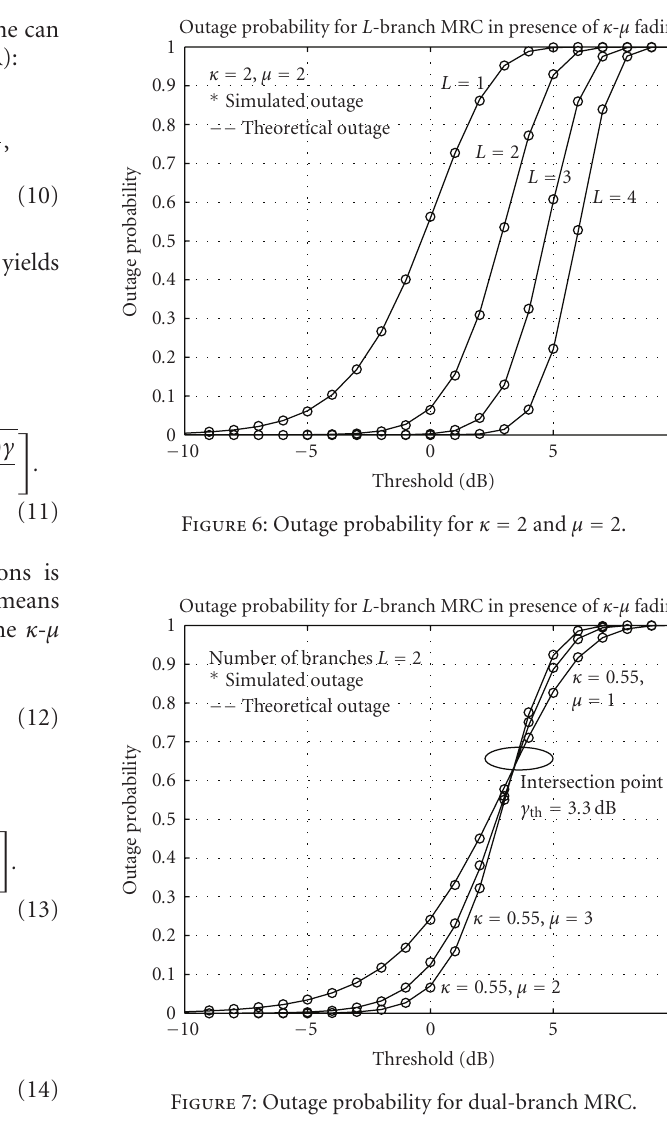
Figure 7: Outage probability for dual-branch MRC.